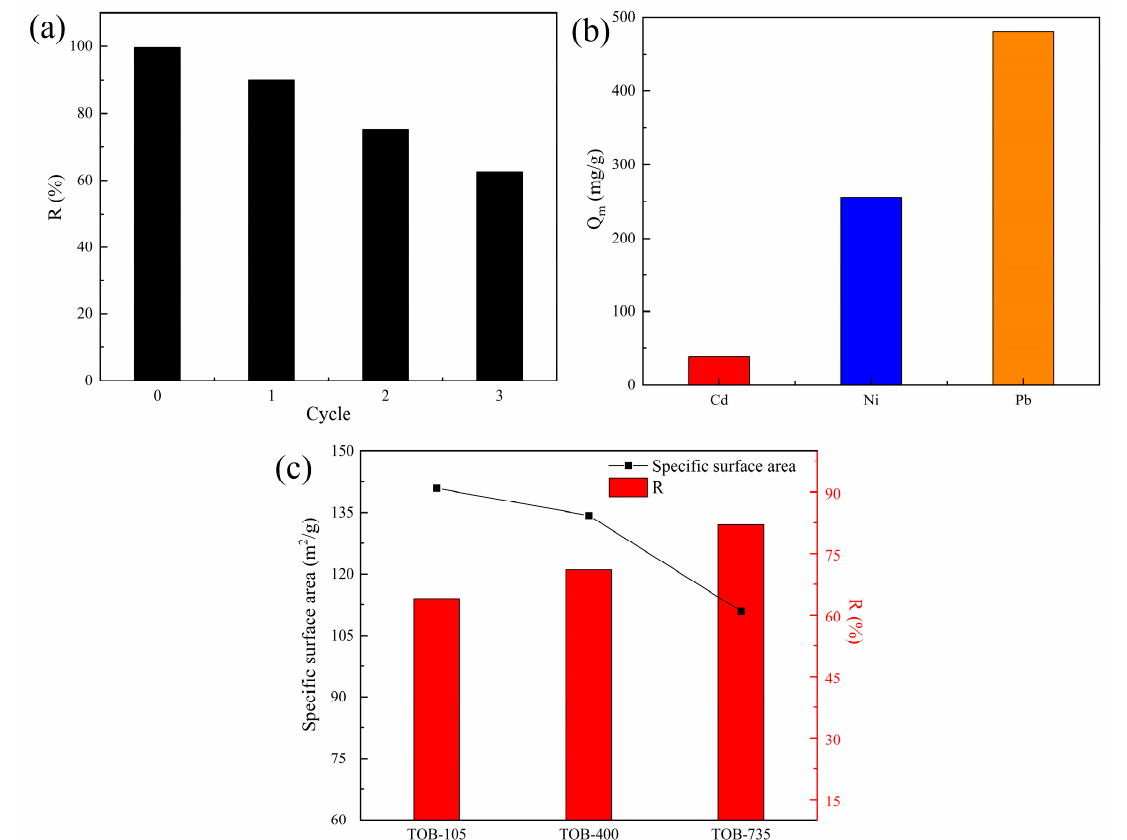
Figure 11. ( a ) Reusability of tobermorite for Cd 2+ adsorption. ( b ) Q m values of tobermorite for Cd 2+ , Ni 2+ and Pb 2+ . ( c ) Specific surface areas and removal efficiency of Ni 2+ with different modified tobermorites.